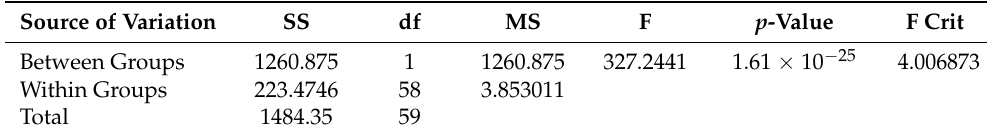
Table 4. ANOVA single factor result between RFA and AI for right foot.